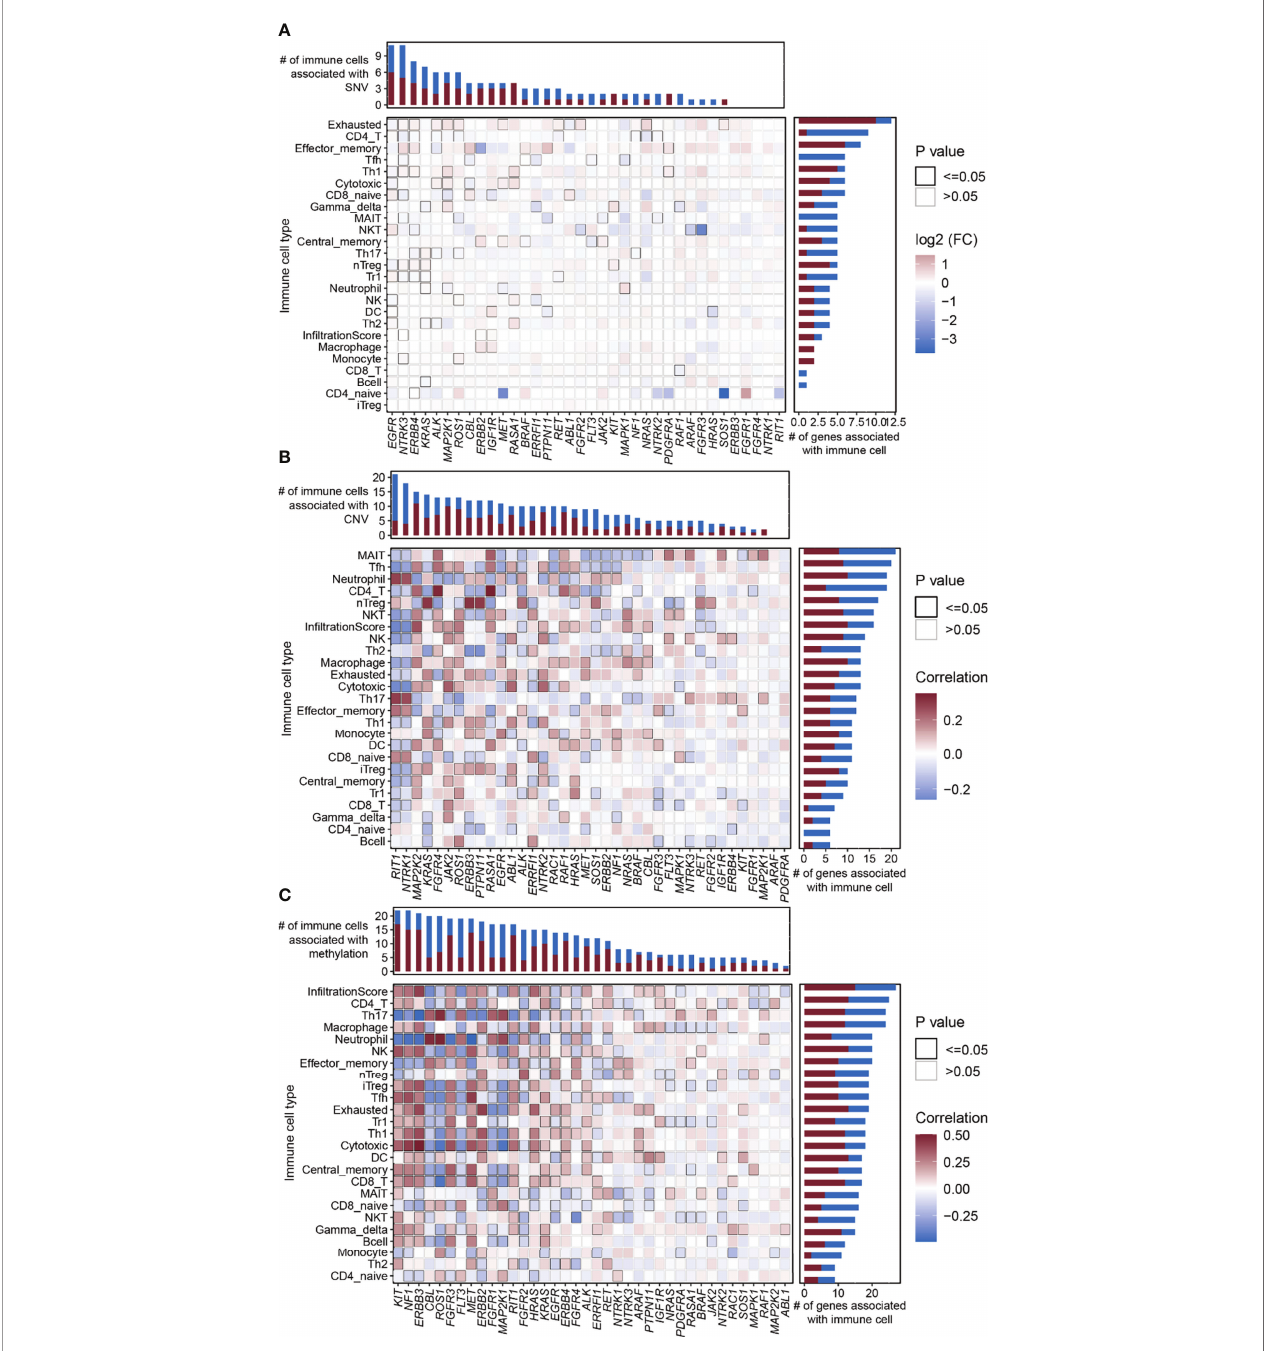
FIGURE 5 | Correlation between the RTK/RAS pathway mutation and abundance of 24 immune cells in LUAD. (A – C) Heatmaps showing Spearman correlation between 24 immune cells/overall in fi ltration score of 24 immune cells and the (B) SNV, (C) CNV, and (D) methylation of RTK/RAS pathway genes. The color of each cell is correlated with the fold change or correlation coef fi cient. The black outline border of each cell indicates P ≤ The performance of the nomograms was evaluated using the status. The OS nomogram model ( Figure 6C ) shared the C-index, which indicates the probability that the predicted predictors of tumor stage, RAC1 methylation, and Tr cell results are consistent with the actual observed results. The C- in fi ltration of DSS. MAP2K1 CNV, HRAS CNV, and CD4 T indices of the nomogram in the training and test sets were 0.728 cell in fi ltration were other OS predictors.